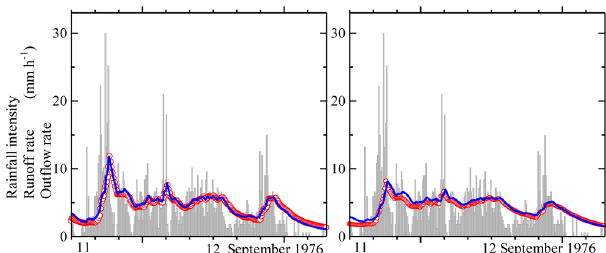
Fig. 4. Storm hydrographs, observed and simulated by TANK, in re- sponse to a typhoon in September 1976 at KT (left) and MN (right) in TEF. Bar: 10min rainfall intensity (displayed in mmh − 1 ) . Red circle: observed runoff rate. Blue line: simulated outflow rate. The lines were calculated by TANK using the functional relationship be- tween storage and the outflow rate given by Eq. (2) with a common p value of 0.3 and k values of 25 for KT and 40 for